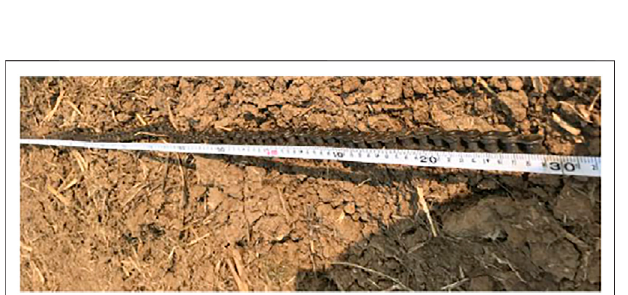
FIGURE 8 | Measurement method of soil surface fl atness.